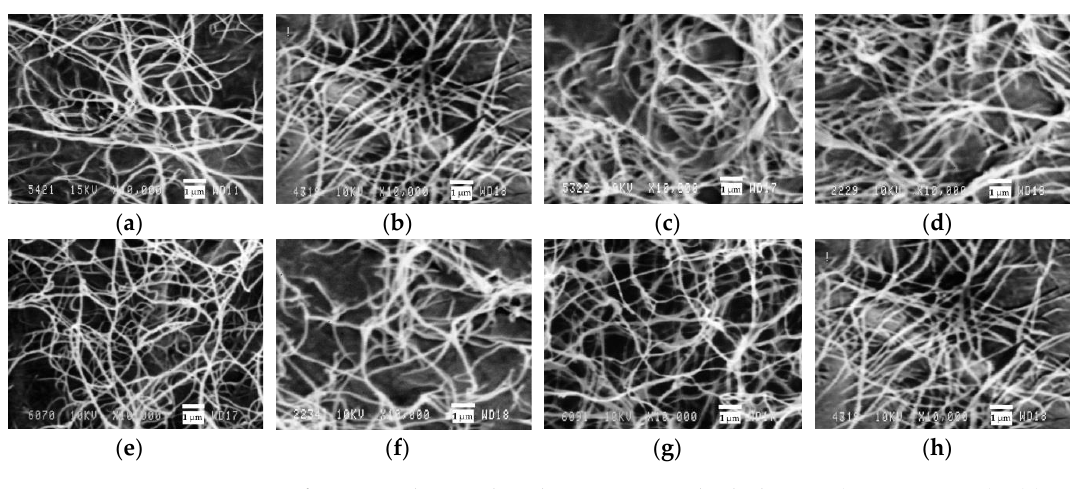
Figure 4. SEM images of BC samples produced in enzymatic hydrolyzates (х10,000 zoom): ( a ) dilute nitric-acid treatment (DNAT) Miscanthus , ( b ) DNAT oat hulls, ( c ) alkaline delignification (AD) Miscanthus , ( d ) AD oat hulls, ( e ) nitric-acid pulping method (NAPM) Miscanthus cellulose, ( f ) NAPM oat-hull cellulose, ( g ) combined pulping method (CPM) Miscanthus cellulose, ( h ) CPM oat-hull cellulose.